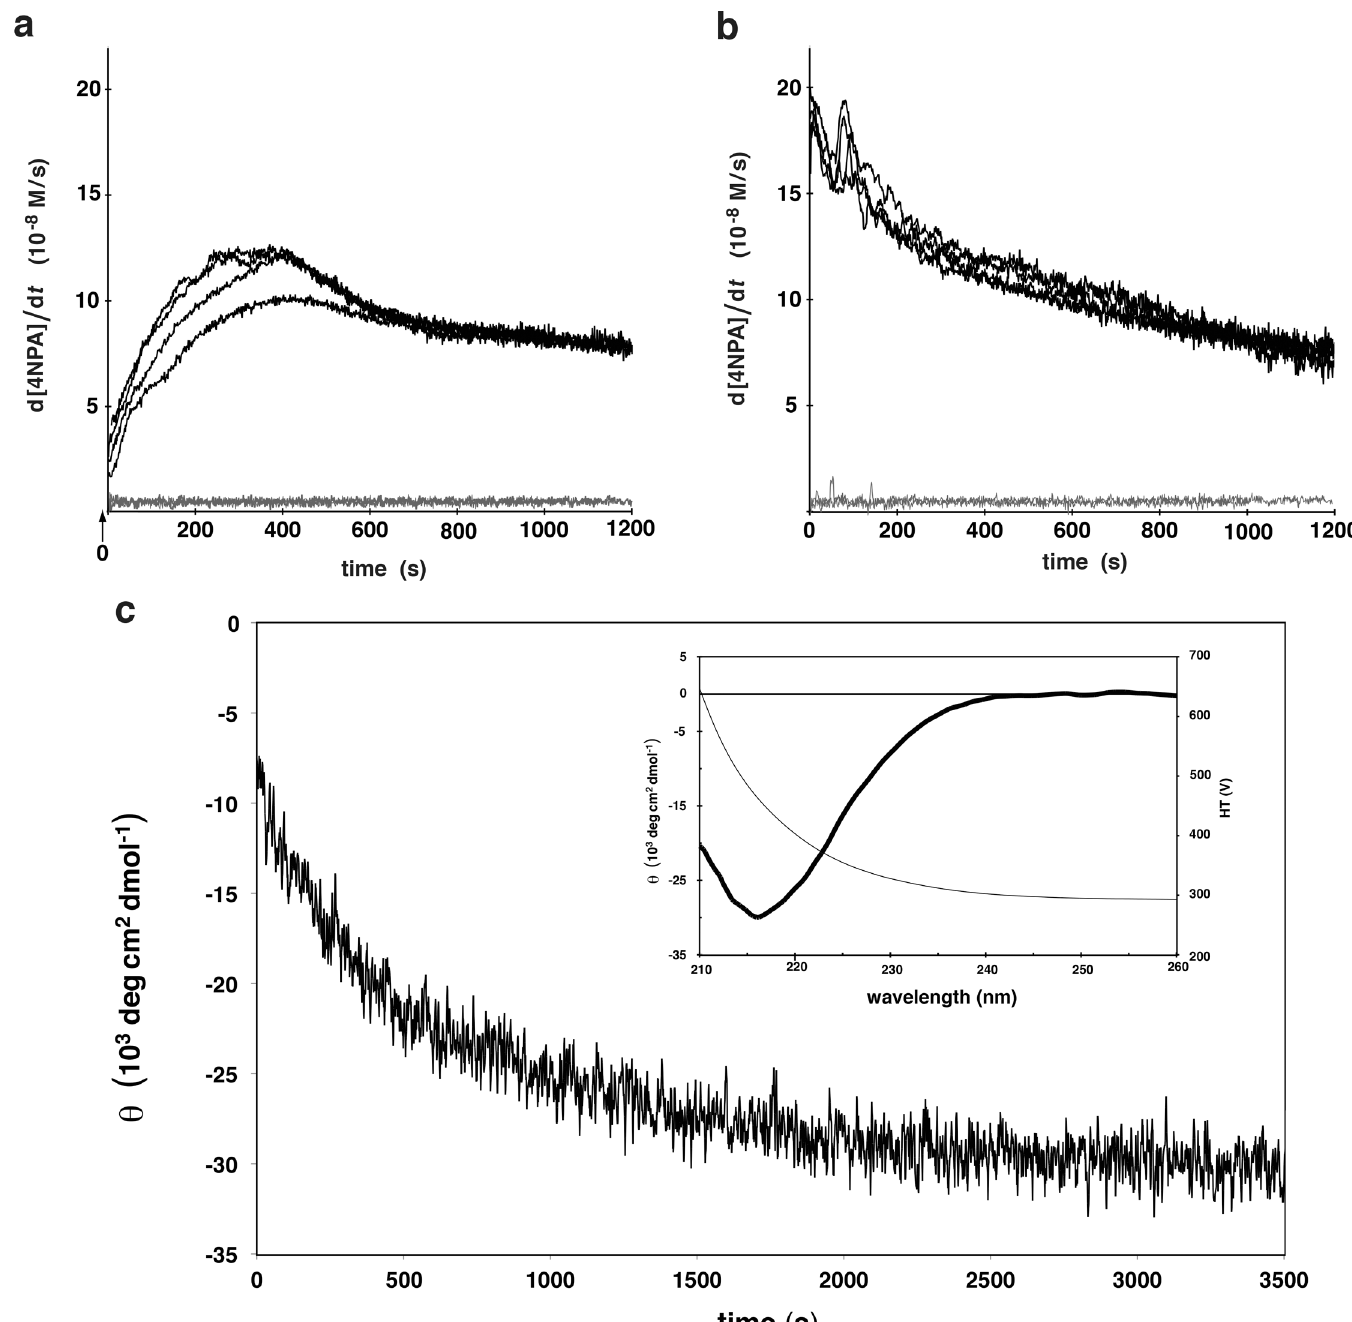
Fig 3. Parallel kinetics of fibrillization and hydrolysis activity. Kinetics of fibrillization measured by CD (c) matches the appearance of the 4NPA hydrolysis activity (a). a) A stock of 35 at 200 μ M in 10 mM HCl was diluted to a final concentration of 50 μ M into 50 mM HEPES pH 7.3 with 0.5 mM ZnCl 2 and 1 mM 4NPA. After ca. 10 s mixing time, the hydrolysis of 4NPA was recorded every 1 s for 20 min at 400 nm and the first derivative of this signal (the instantaneous rate) is plotted as a function of time. The black lines are four independent measurements of these and the grey lines are two measurements of the background reaction ( i . e . without peptide). b) Aggregates of 35 were prepared as in (a) except in the absence of substrate. After 1 h, 1 mM 4NPA was added and the hydrolysis rate was monitored. Once again, the black curves are 4 separate measurements and the grey lines 2 background measurements. c) Peptide 35 was prepared as in (a) and the CD signal at 218 nm was measured every 2 s starting ca. 12 s after mixing. The inset plot shows the CD spectrum of the sample after 1 h and the detector voltage (scale on the